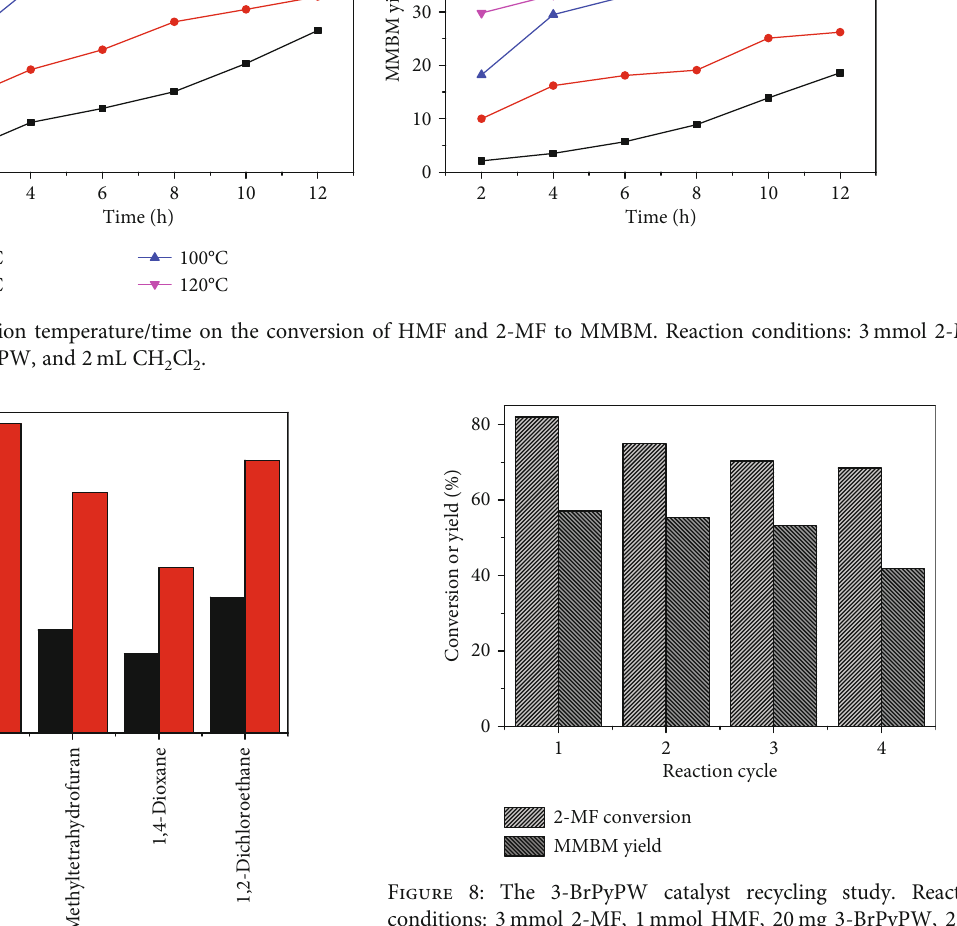
Figure 8: The 3-BrPyPW catalyst recycling study. Reaction conditions: 3 mmol 2-MF, 1 mmol HMF, 20 mg 3-BrPyPW, 2mL CH Cl , 100 ° C, and 2 2